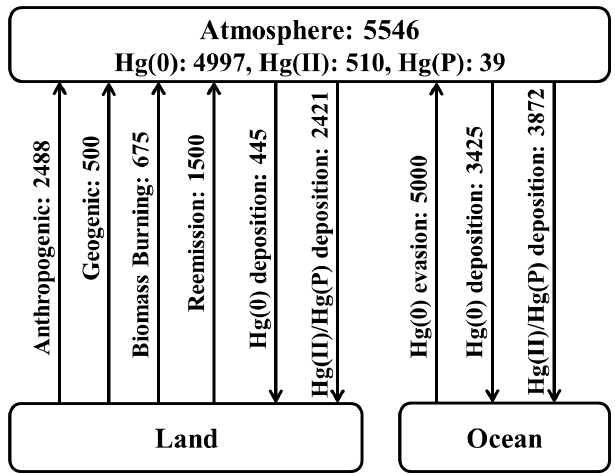
Figure 2. Global atmospheric mercury budget in GNAQPMS-Hg (in Mgyr − 1